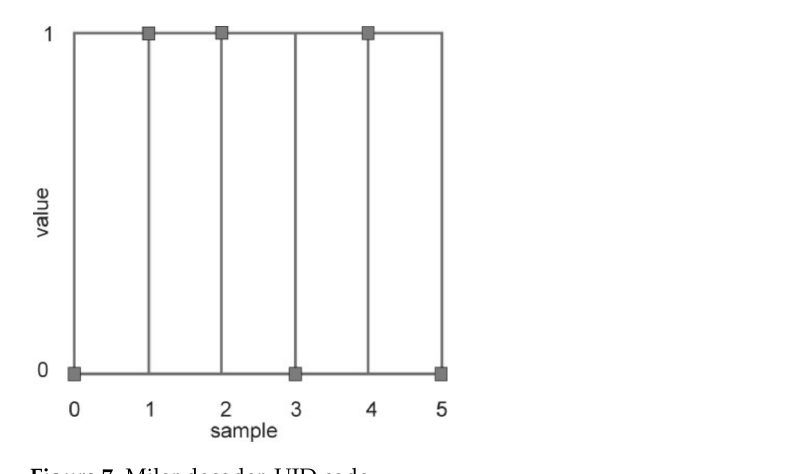
Figure 7. Miler decoder, UID code.